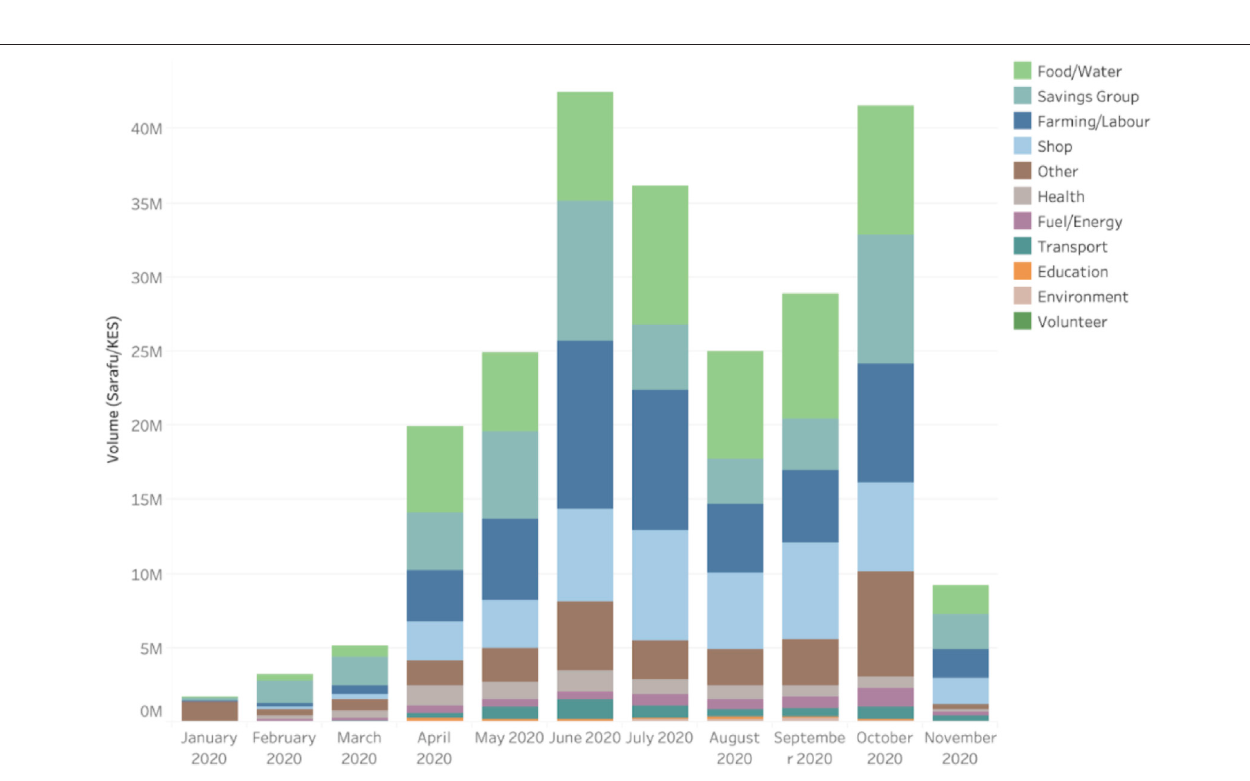
FIGURE 4 | Sarafu monthly trade volume by category (Grassroots Economics, 2020).